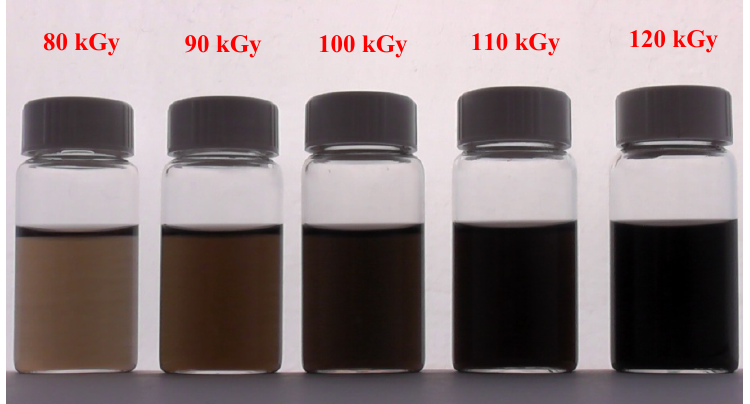
Figure 1. Photographs of colloidal Pt nanoparticles synthesized by the gamma radiolytic reduction method at doses of 80 to 120 kGy showing the colour of the colloidal solutions gradually turning from brown to dark brown, indicating evidence for the formation of Pt